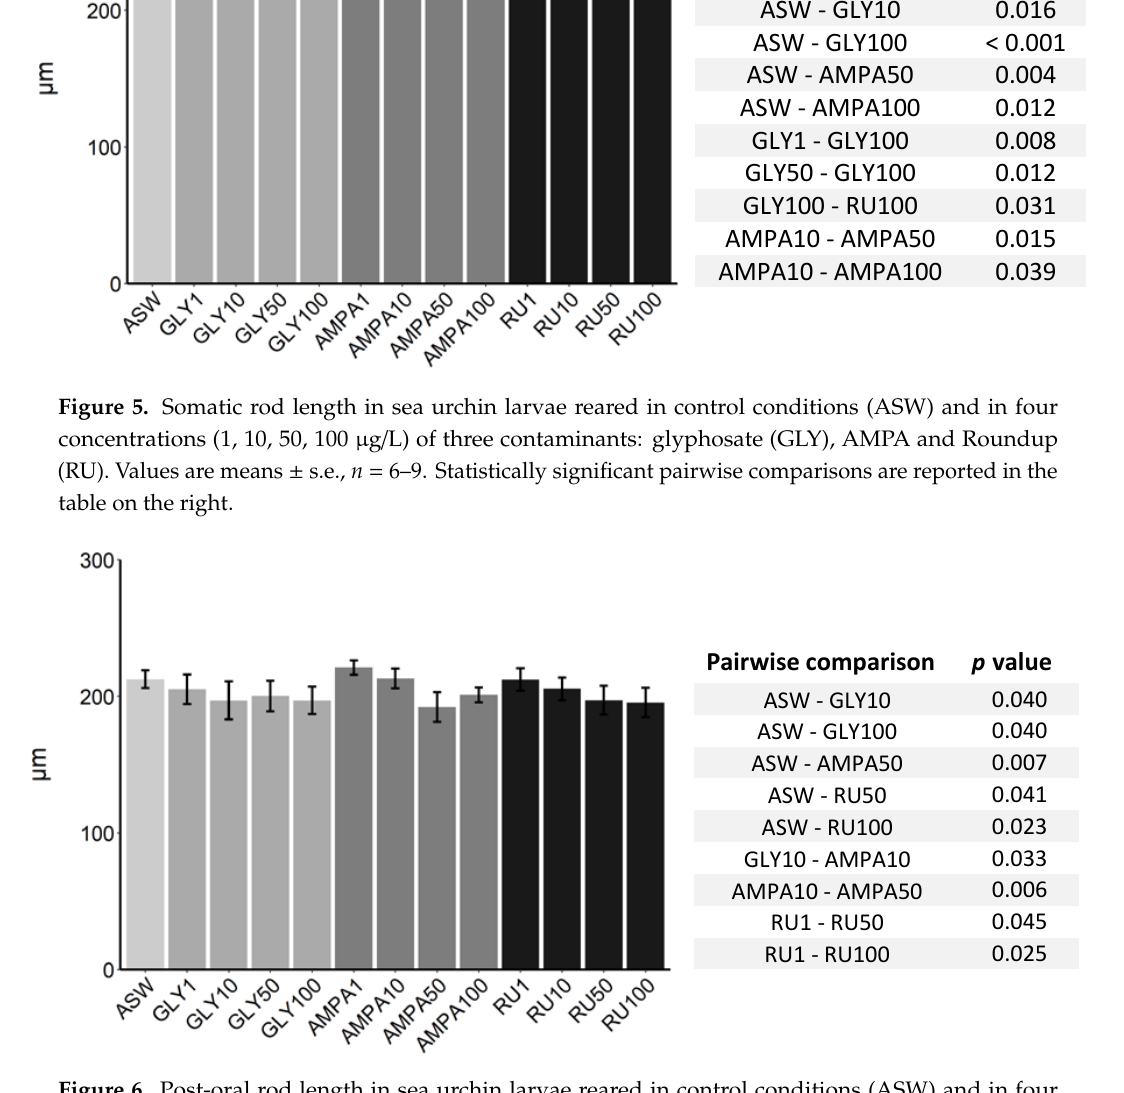
Figure 6. Post-oral rod length in sea urchin larvae reared in control conditions (ASW) and in four concentrations (1, 10, 50, 100 µ g / L) of three contaminants: glyphosate (GLY), AMPA and Roundup (RU). Values are means ± s.e., n = 6–9. Statistically significant pairwise comparisons are reported in the table on the